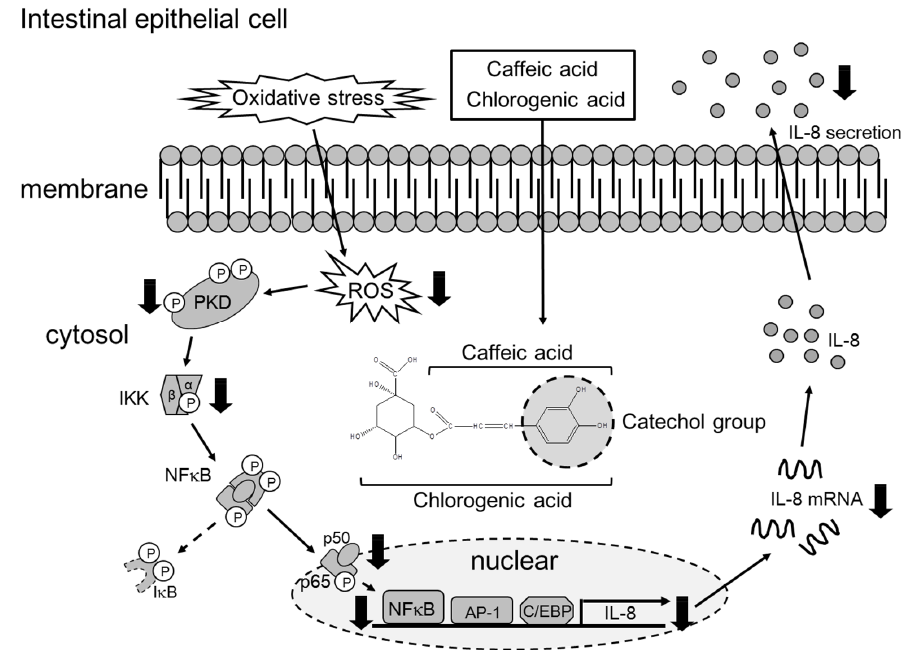
Figure 6. Proposed anti-inflammatory mechanism of chlorogenic acid (CHA) and caffeic acid (CA) in human intestinal epithelial cells.